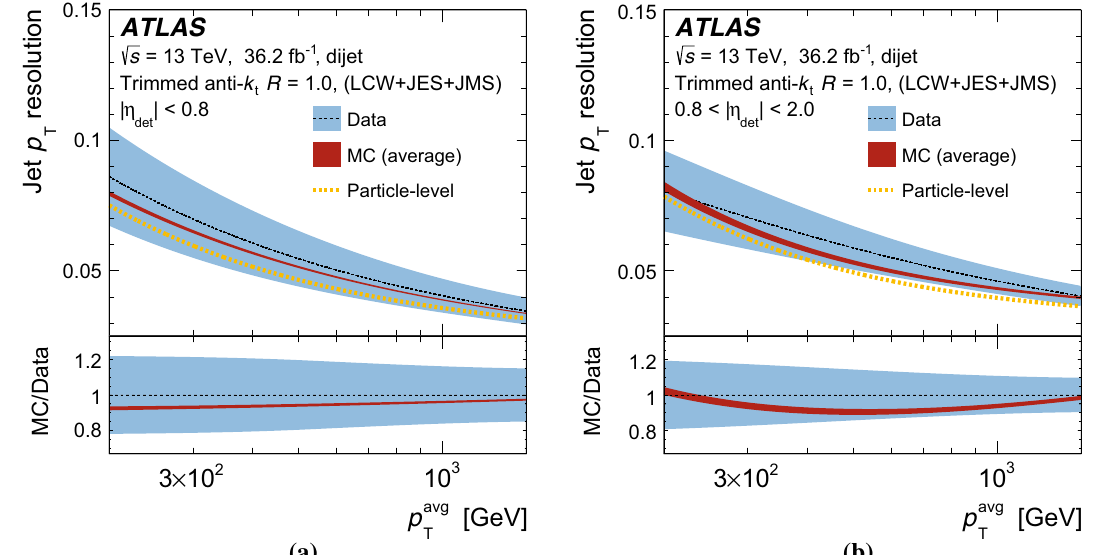
Fig. 23 Comparison of the measured jet p T resolution with the resolu- tion determined in simulation, averaged between different generators as a function of the average jet p T and in two bins of detector pseudorapid- ity η det from a | η det | < 0 . 8 and from b 0 . 8 < | η det | < 2 . 0. The large- R jet p T is corrected using the simulation calibration, η -intercalibration, and a combination of in situ direct balance techniques. The error band, drawn as a light band, represents the statistical and systematic uncer- taintiesaddedinquadrature.Thedeterminationoftherelativeresolution